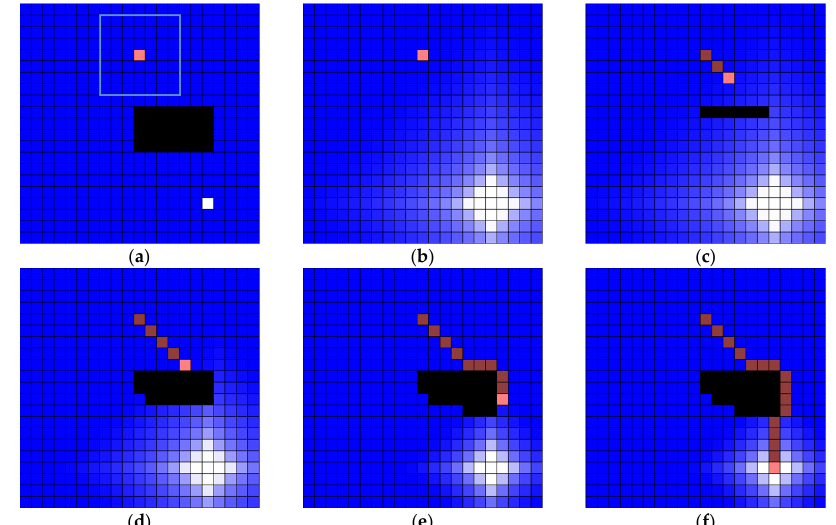
Figure 15. An example of simulation for dynamic environment. Workspace includes 21 × 21 cells whose size is 20 pixels: ( a ) there is a 7 × 4 sized obstacle and the sensing area of robot is 7 × 7 cells; ( b ) the sensor of robot could not detect any obstacle and water drainage is occurred at first; ( c ) the obstacle could not interfere with the robot path; ( d ) the robot path is disturbed by an obstacle and water drainage is occurred again; ( e ) the robot path is disturbed by obstacle again and water drainage is occurred again; and, ( f ) the final result of water sink model.